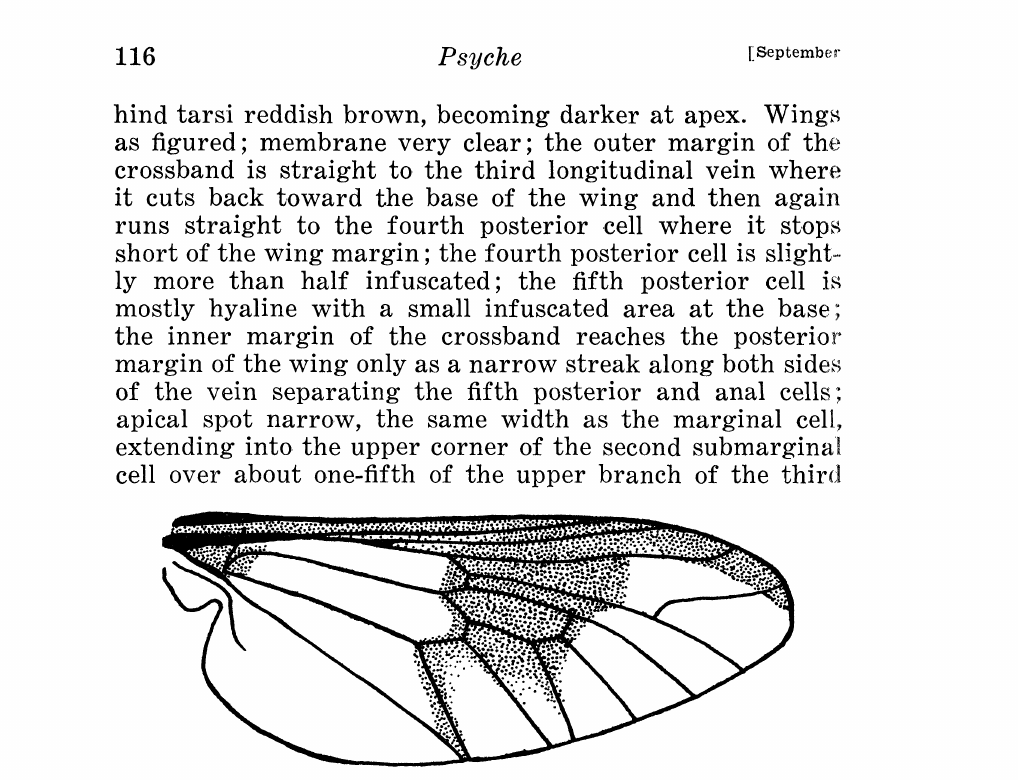
Fig. 1. Chrysops patricia Pechumtn n. sp.